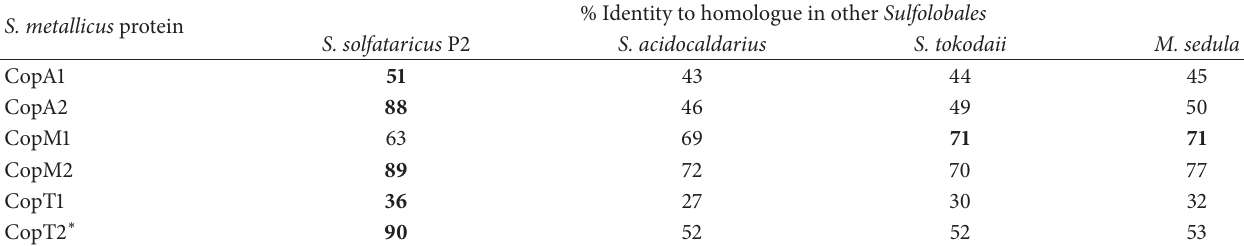
Boldface type indicates to which organism the S. metallicus homologue shows the highest sequence identity. ∗ Refers to the analysis obtained using the uncompleted amino acid sequence of CopT2, which represents ∼ 90 % in length when compared with S. solfataricus CopT